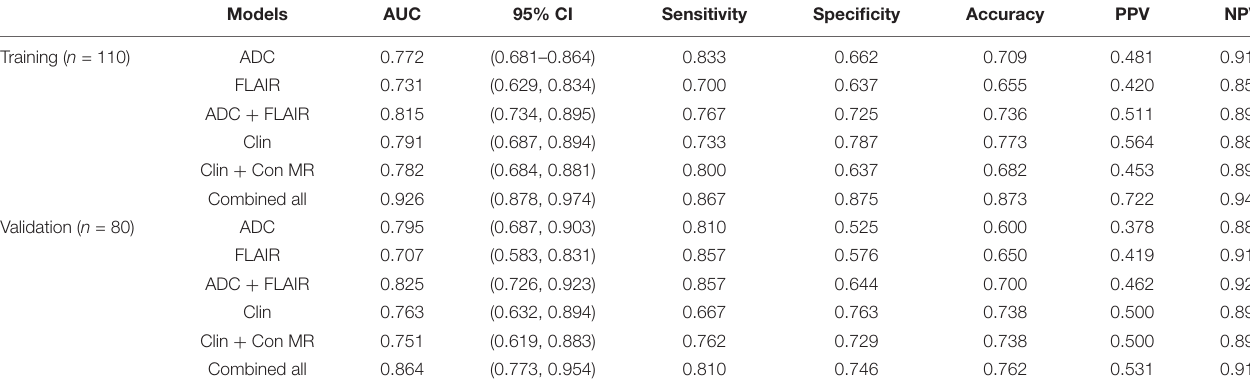
TABLE 4 | The diagnostic performance of the prediction models. Models AUC 95% CI Sensitivity Specificity